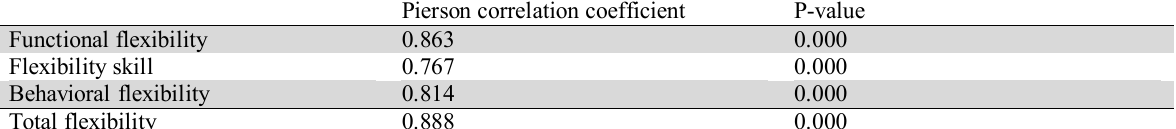
Pierson correlation coefficient